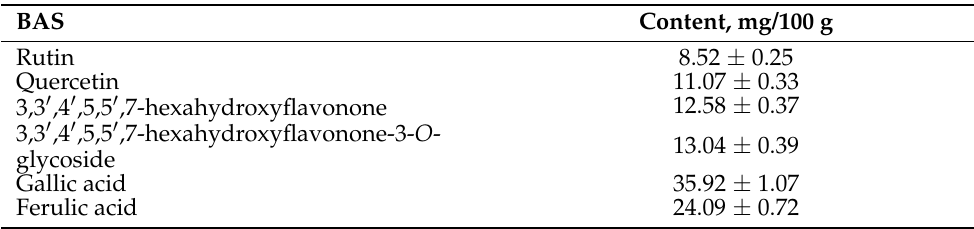
Table 3. The results of the quantitative determination of individual BAS from the Dactylorhiza maculata